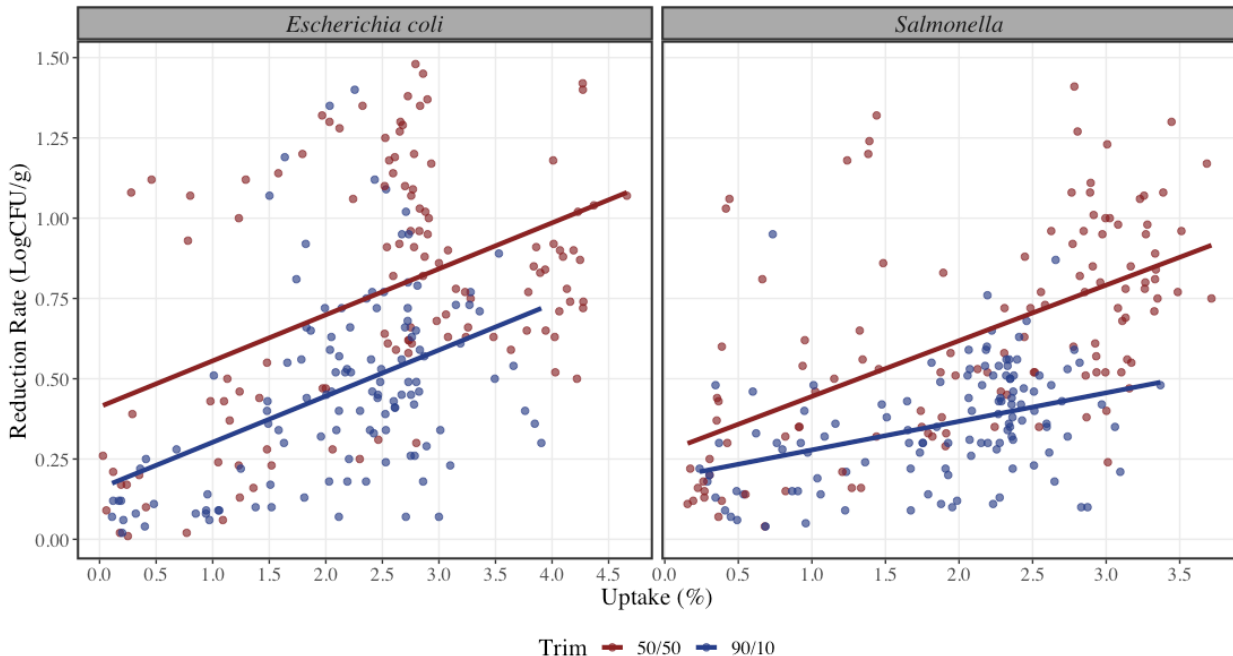
Figure 4. Reduction rate of Shiga-toxin producing Escherichia coli and Salmonella spp. at different uptake percentages ( n = 240 per microorganism) when using two different lean levels (90/10 (blue) and 50/50 (red); lean to fat ratio). The solid line represents a linear regression model with Uptake (%) as independent variable and Reduction (LogCFU/g) as dependent variable for each pathogen bacteria. The dots represent the actual data points.